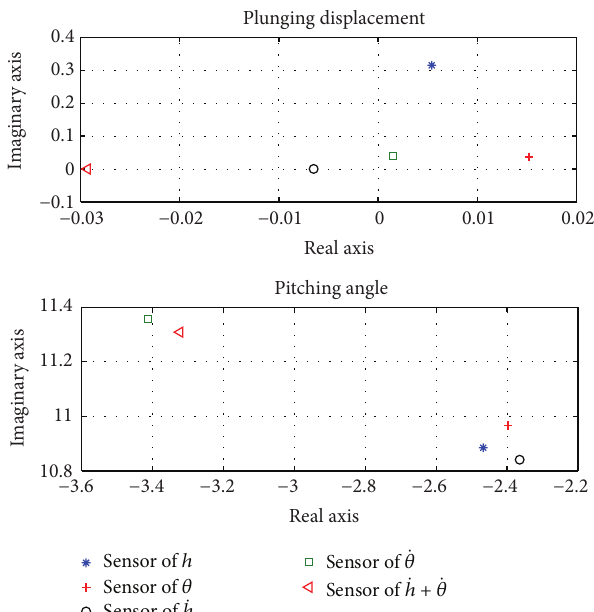
Figure 10: Closed-loop eigenvalues of the system with different sensor signals for deep stall